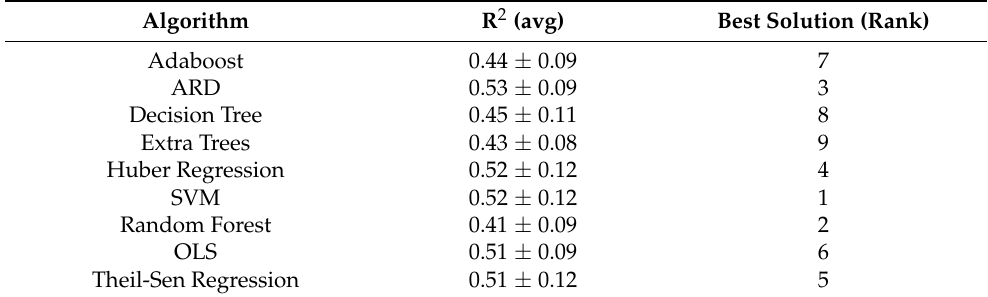
Table 8. List of the algorithms used in AutoML to assess their performance in evaluating grape quality attributes, the corresponding R 2 values and the ranking of each algorithm.